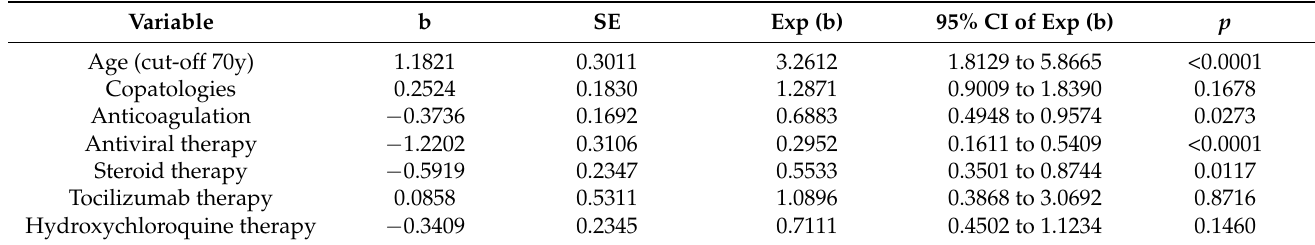
Table 2. Multivariate